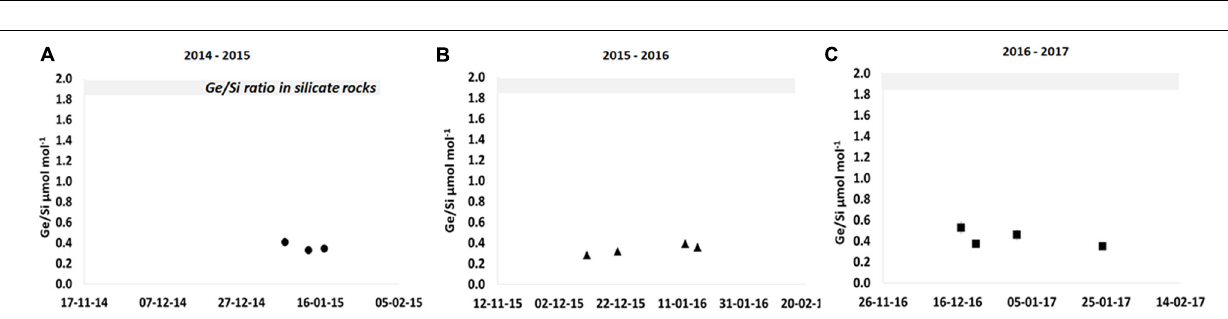
FIGURE 4 | Ge/Si ratios in < 0.4 µ m filtered water from Crescent Stream for samples collected between December and February 2014–2015 (A) ; 2015–2016 (B) ; 2016–2017 (C) . The gray bar represents the lower bound for Ge/Si ratios in silicate rocks (Bernstein, 1985). The precision on Ge/Si ratios (10%) is included in the marker